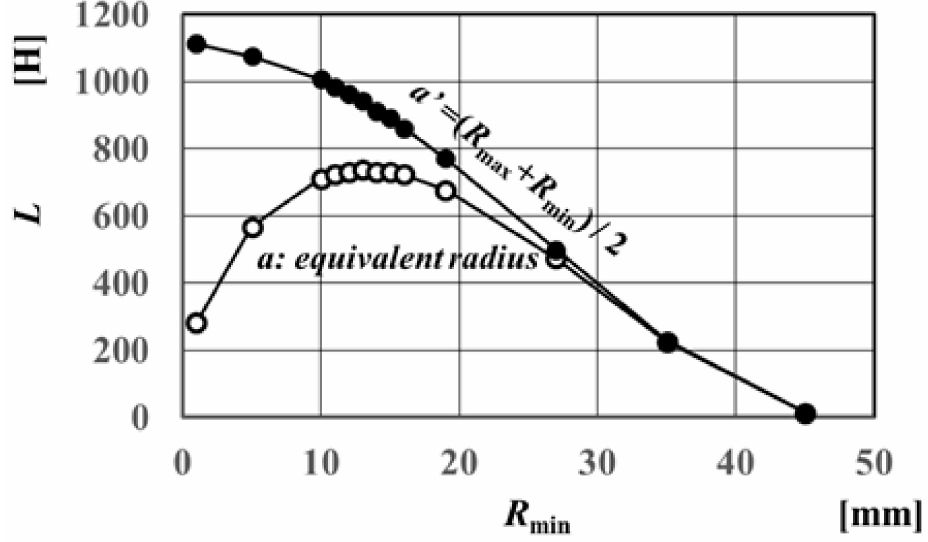
Figure 12. Inductance L of the single-layer solenoid of the length m · t = 30 cm as a function of R min calculated employing the radius a and a